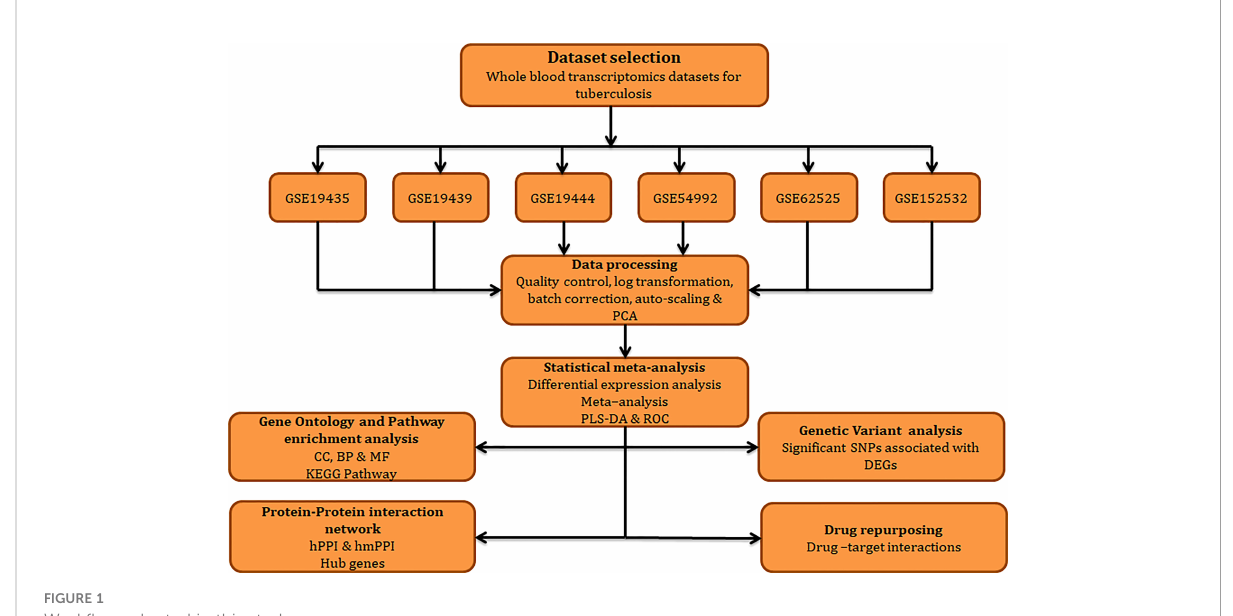
FIGURE 1 Work fl ow adopted in this